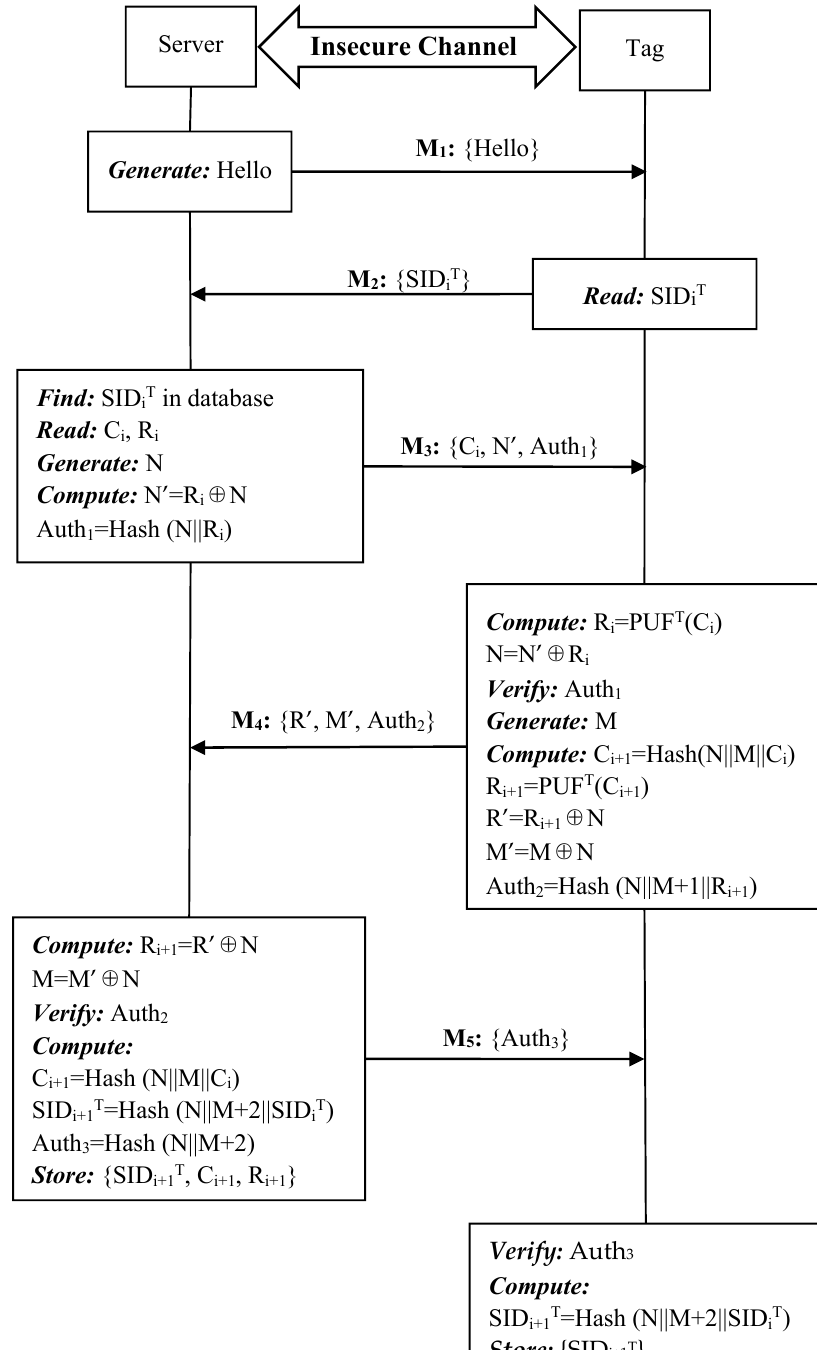
Figure 5. Authentication phase of the proposed ideal PUF-based protocol.